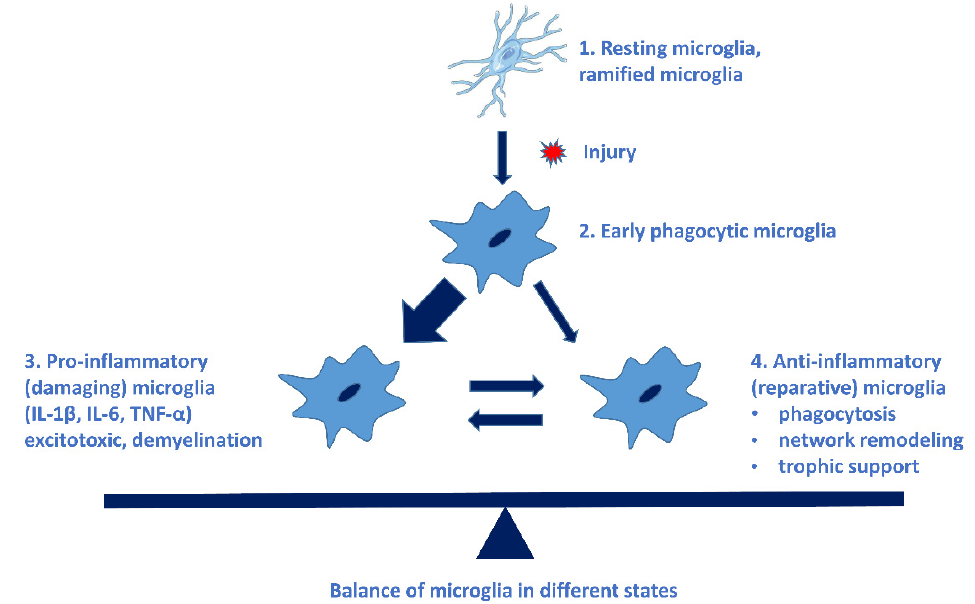
Figure 1. Different types of microglial cells, their characteristic cytokines, and their roles in cellular processes. The imbalance of pro- and anti-inflammatory microglia leads to the progression of NDDs. (See Ref. [31]).